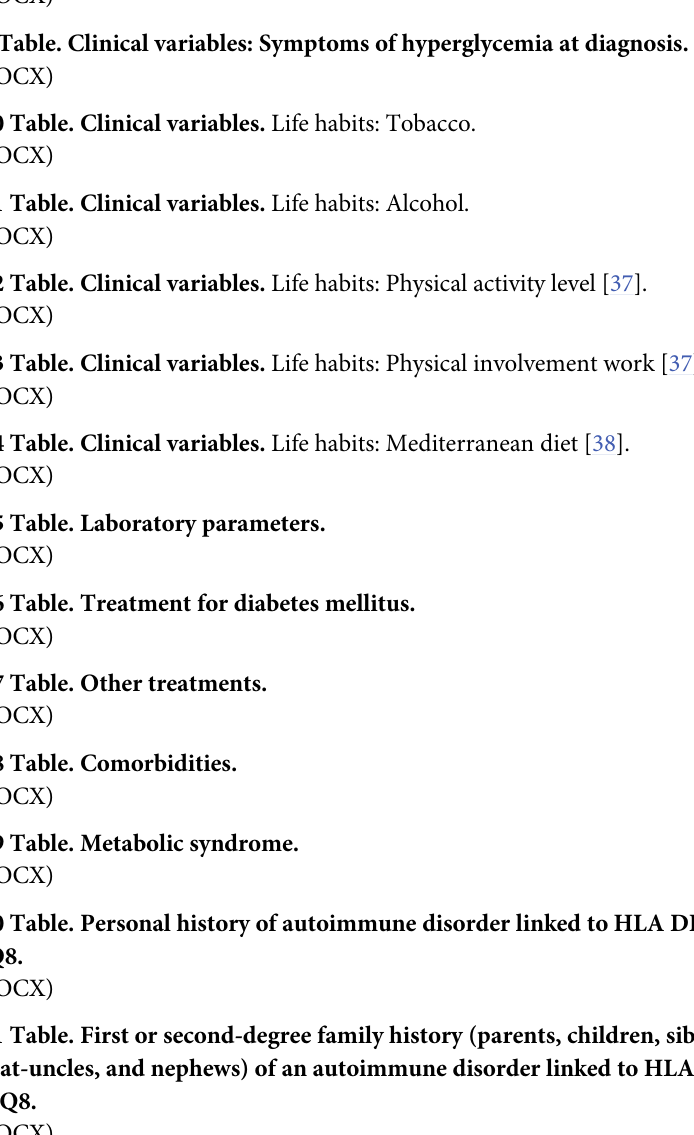
S16 Table. Treatment for diabetes mellitus. S17 Table. Other